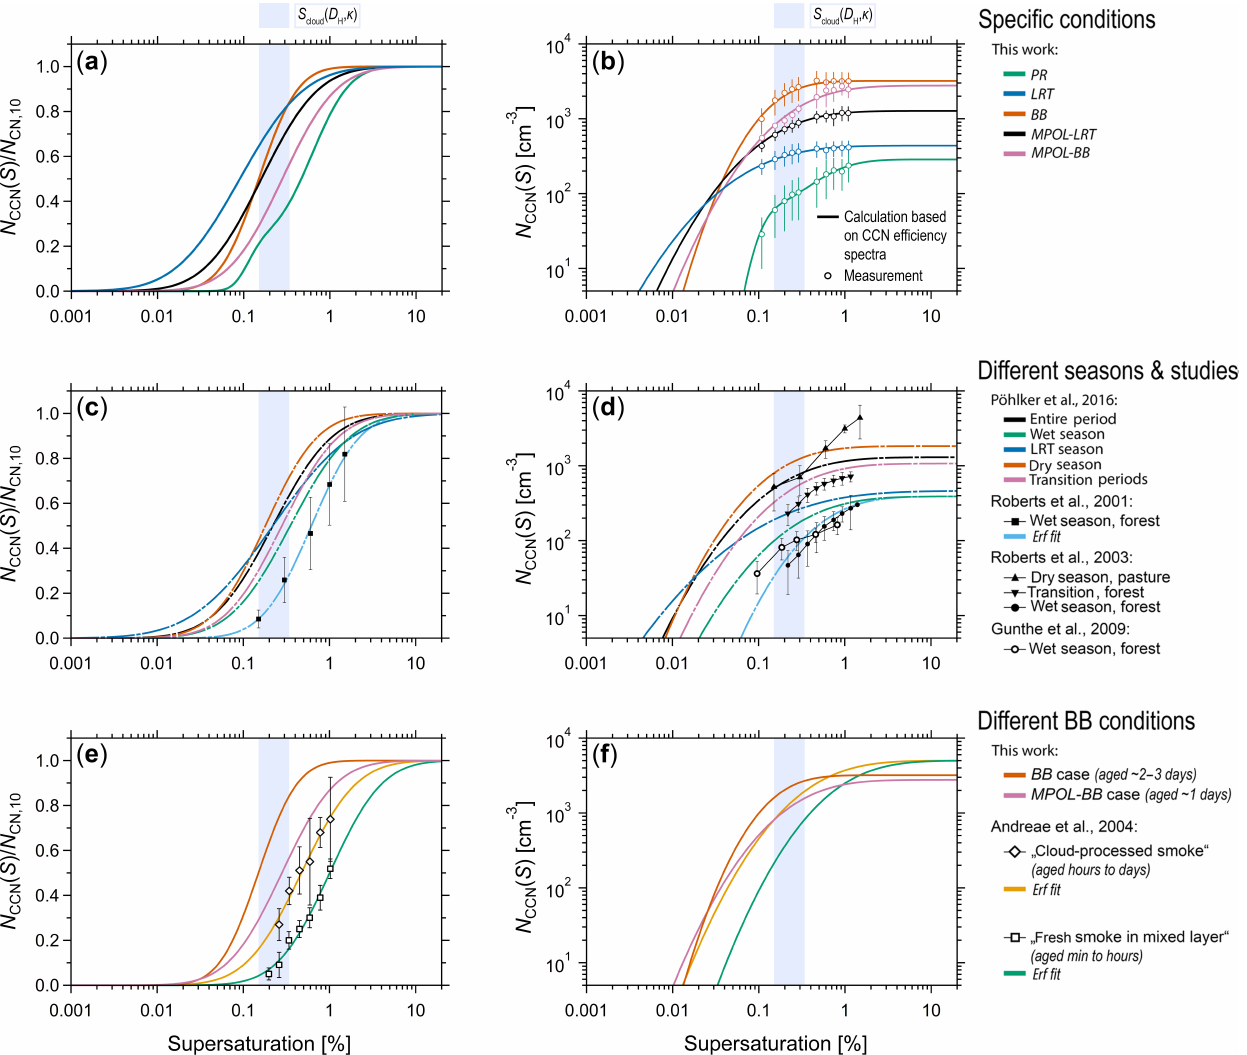
Figure 11. Overview and comparison of normalized CCN efficiency spectra and number-concentration-based CCN spectra for characteristic conditions and seasons. ( a and b ) PR, LRT, BB, MPOL-LRT, and MPOL-BB conditions as defined in this paper. ( c and d ) Seasonally averaged spectra from the Part 1 companion paper (Pöhlker et al., 2016), CCN efficiency spectrum from Roberts et al. (2001), and CCN spectra from Roberts et al. (2003) and Gunthe et al. (2009). ( e and f ) Conditions representing different aging states of biomass burning aerosols based on BB and MPOL-BB conditions from present work and data from a previous study by Andreae et al. (2004). For clarity the erf fit with the pre-defined variable a 1 = 1 was used for the BB case (compare Fig. 6f). CCN spectra in (b) were obtained from multiplication of CCN efficiency spectra in (a) with corresponding average aerosol number concentrations in Table 4. Markers represent measured average CCN concentrations for case study periods. Error bars at markers represent 1SD. Good agreement of CCN spectra and markers underlines reliability of CCN efficiency spectra in representation of CCN population. Blue vertical shading represents estimated peak supersaturations at cloud base, S cloud (D H , κ ), in the ATTO region according to Pöhlker et al. (2016) and the present study. The colors were chosen according to Wong